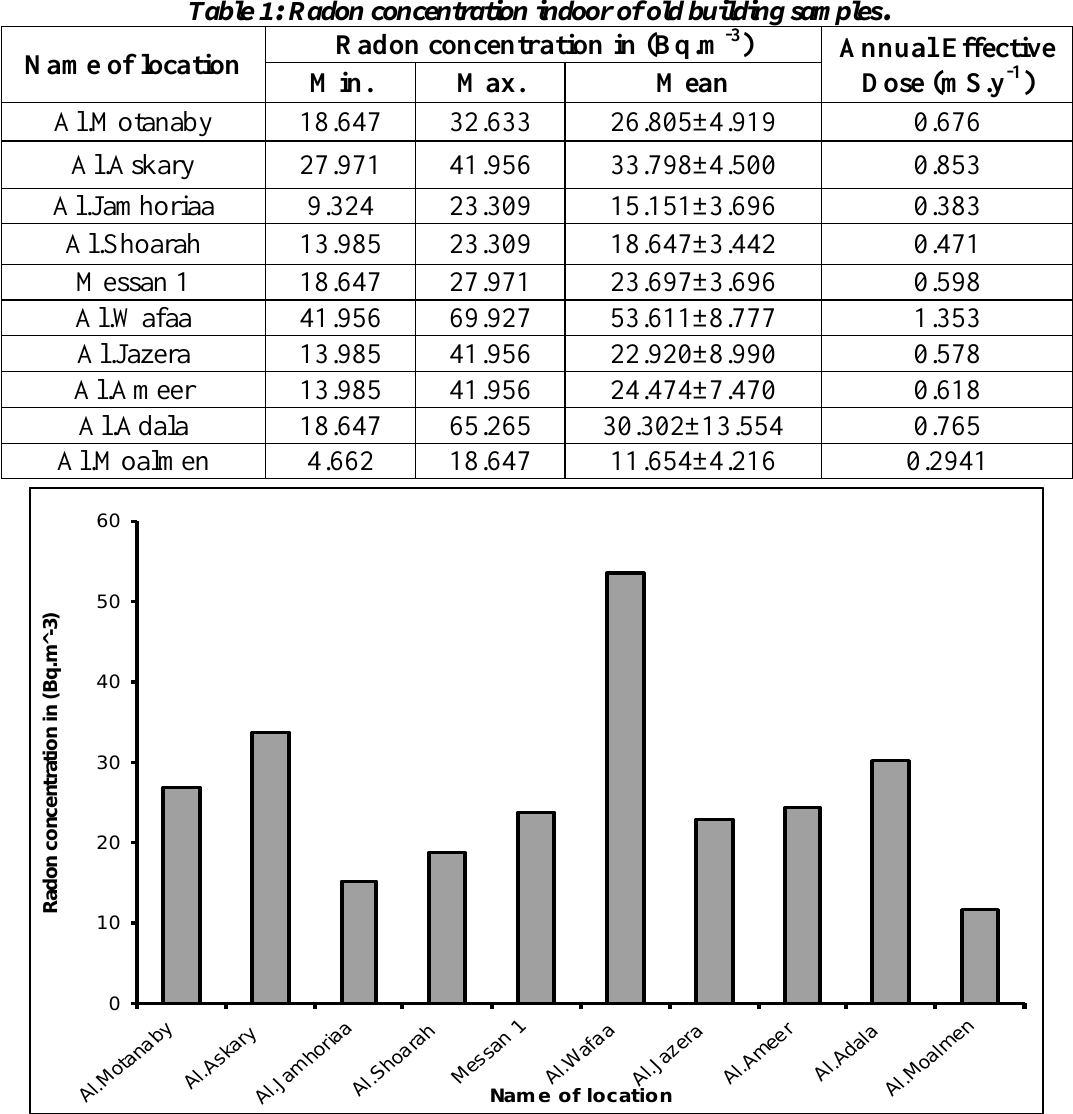
Fig.3: The average concentration of radon indoor of old building samples for study